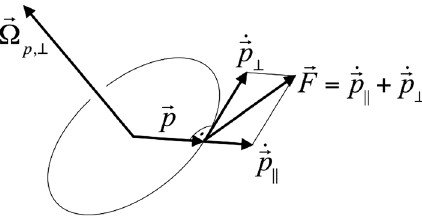
FIG. 1. Angular frequency describing the rotation of the direction of the particle